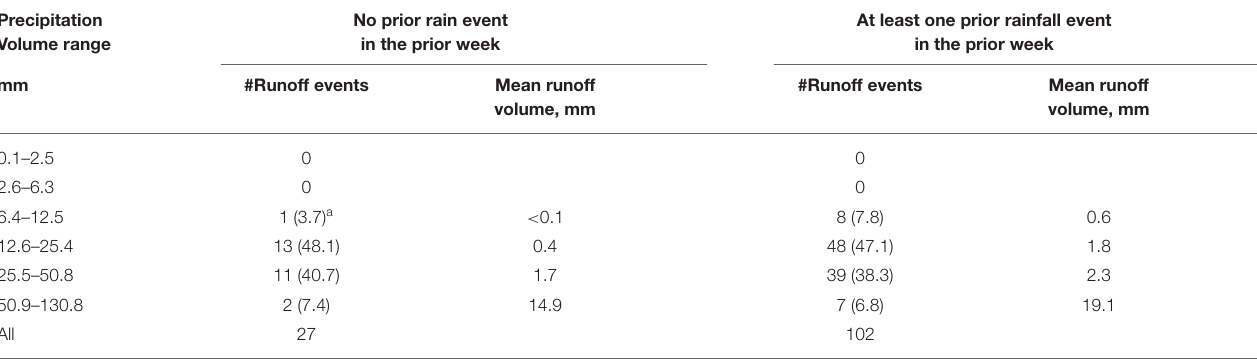
TABLE 5 | Comparing runoff frequency and mean runoff volume for isolated storms and those storms that were followed by at least one rainfall event in the week prior. Precipitation Volume